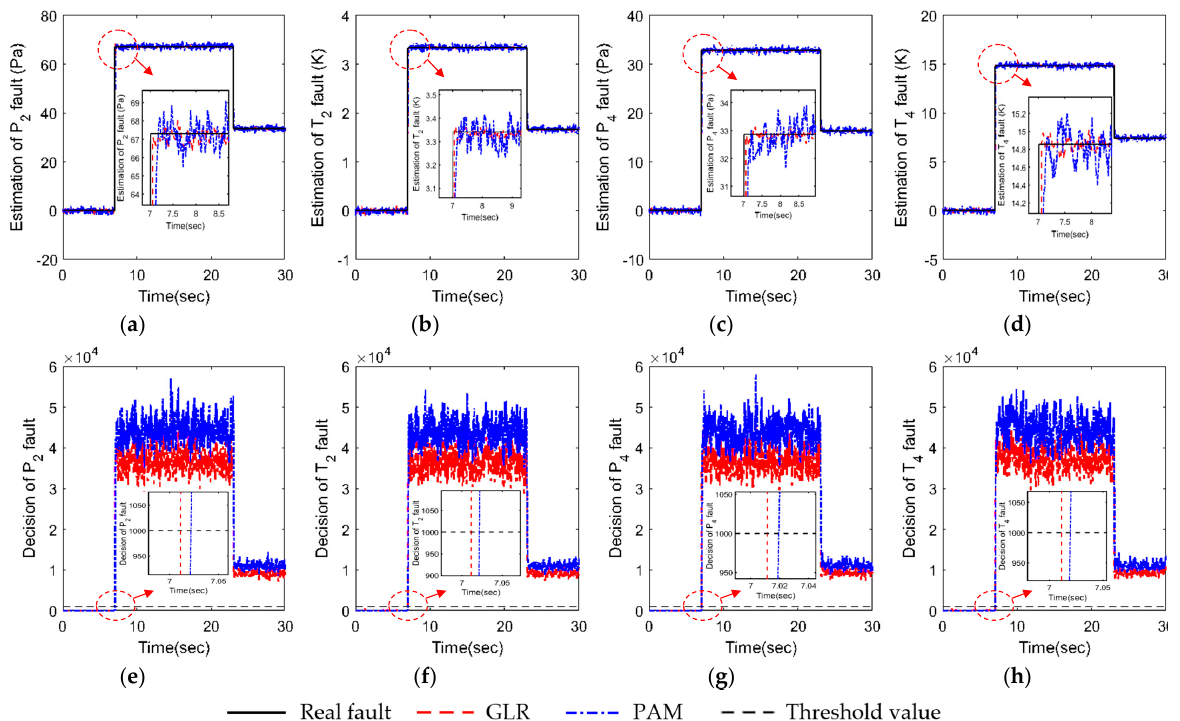
Figure 5. Simulation results: FD of the sensor faults: ( a ) fault estimation of P 2 ; ( b ) fault estimation of T 2 ; ( c ) fault estimation of P 4 ; ( d ) fault estimation of T 4 ; ( e ) FDI of P 2 ; ( f ) FDI of T 2 ; ( g ) FDI of P 4 ; ( h ) FDI of T 4.